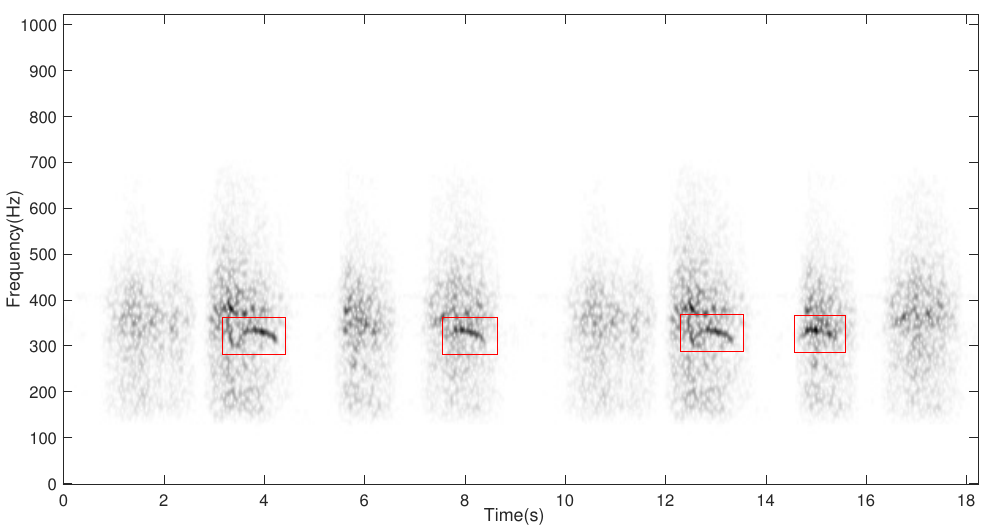
Figure 1. Time-frequency representation of a breathing recording from an unhealthy subject in which four wheezes (red rectangles), mixed with normal respiratory sounds, can be observed. Higher energies are indicated by darker